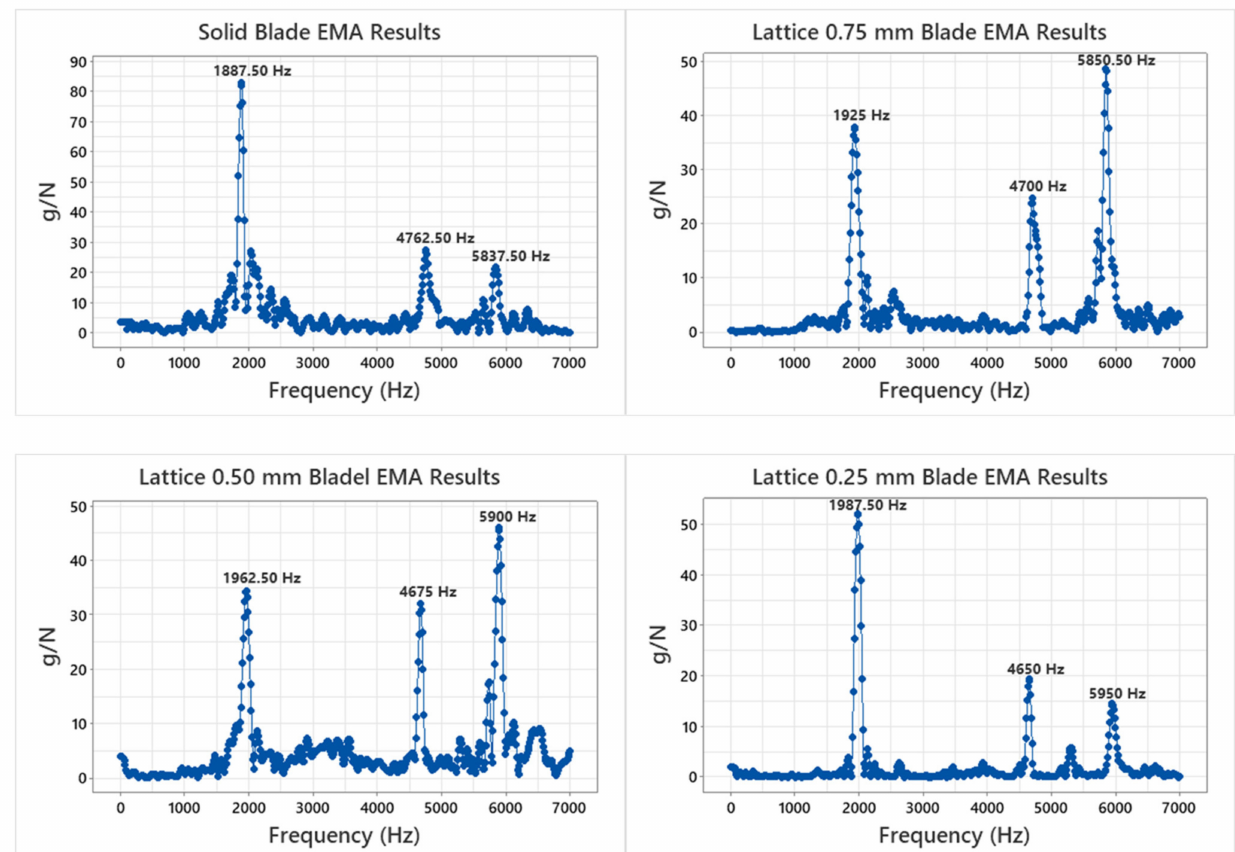
Figure 7. Experimental modal analysis